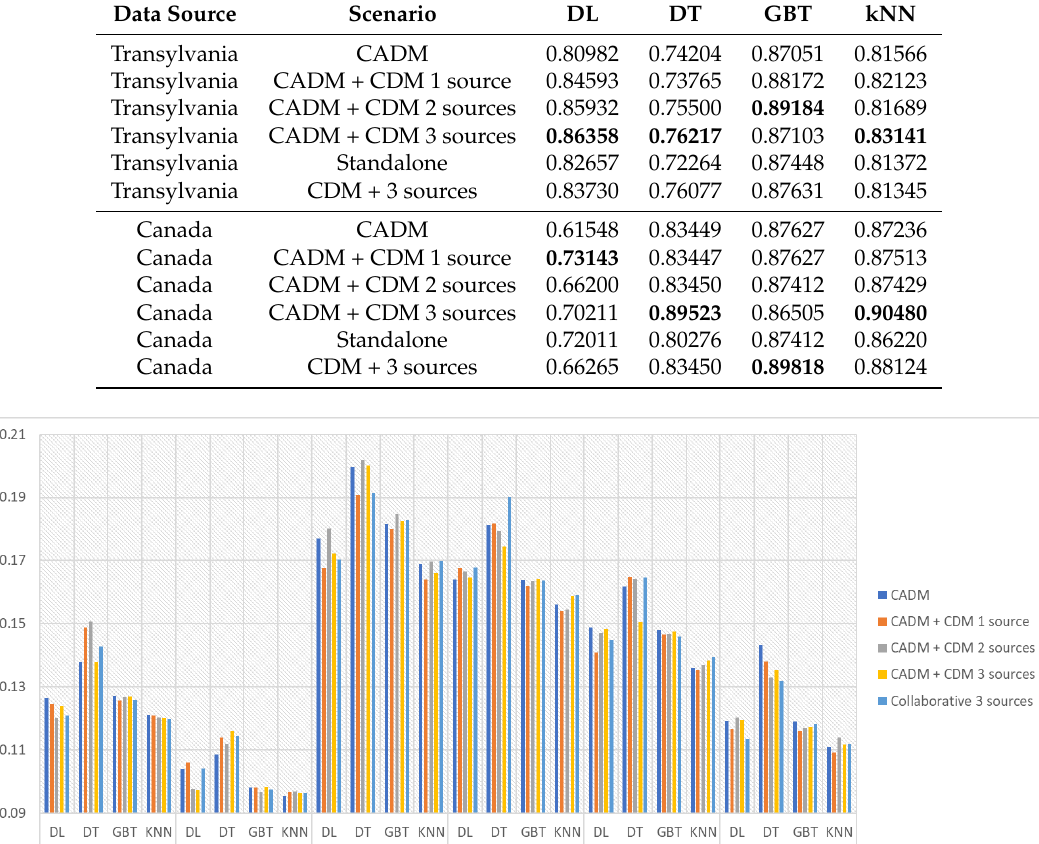
Table 7. Spearman ρ overall results for Data Sources [29,30] described in Table 2 and tested scenarios. Data Source